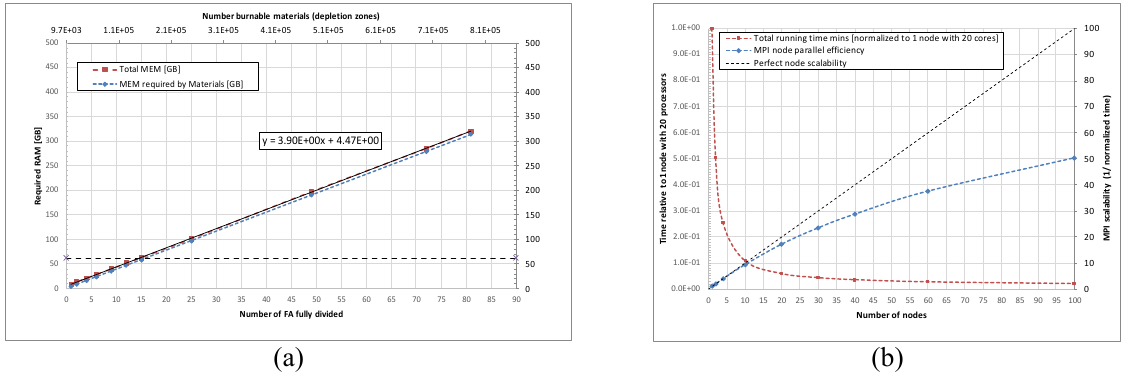
Figure 1: Multithread memory requirement (a) and parallel scalability